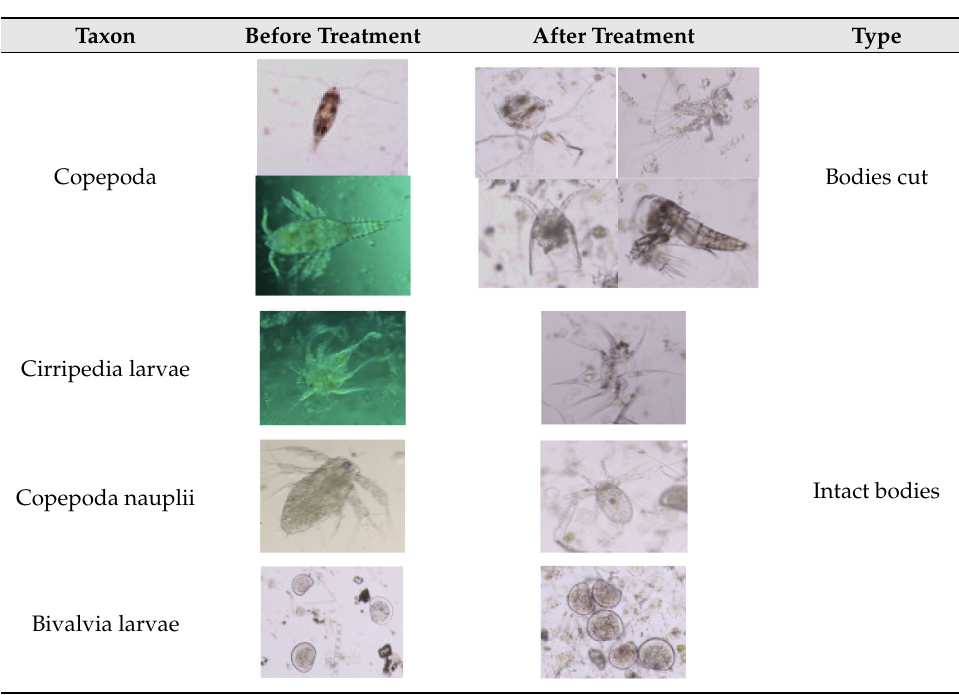
Table 7. Photographs of major zooplankton species treated by GE BWMS pre-treatment system during pilot test period in the 8th test